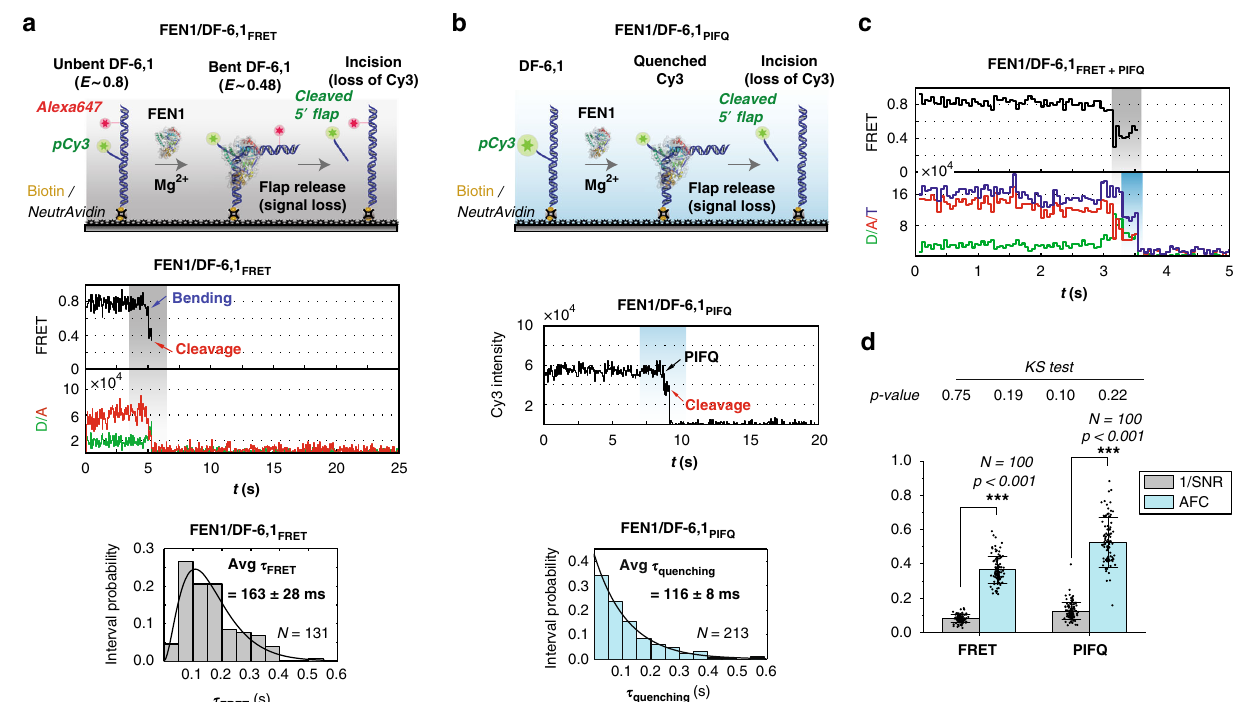
Fig. 5 PIFQ can be used at the single-molecule level to infer FEN1 catalytic kinetics. a smFRET cleavage assay used to follow the catalytic kinetics of FEN1 on DF-6,1 substrate. Top: schematic representation of the experimental approach. Bottom: representative single-molecule trace of a cleavage event showing the FRET change and the following loss of signal. The distribution of the time spent in bent state for N = 131 cleavage events was plotted and fi tted with gamma distribution. The mean and standard error of the mean are reported. b Single-molecule cleavage assay (smPIFQ) with a single label (pCy3) placed at the tip of the fl ap. Top: schematic showing the design of the assay. Bottom: representative single-molecule trace monitoring the fl uorescence quenching of pCy3 upon interaction with FEN1 and subsequent signal loss. The time spent in the quenched-state is quanti fi ed for N = 213 events and its distribution is plotted and fi tted to an exponential decay, with the mean and standard error of the mean reported. c Representative smFRET trace showing the FRET change (highlighted in gray) and the total intensity change (highlighted in cyan) before the signal loss. The total intensity change corresponds to the quenching of the Cy3 signal. d Bar chart showing the reciprocal of the signal-to-noise ratio (1/SNR-shown in gray) and the absolute fractional change (AFC-shown in Cyan) (light blue) for smFRET and smPIFQ cleavage traces as described in SI Methods section. The error bars correspond to the standard errors of the mean (SEM) of the 1/SNR and AFC in each case. The analysis was performed using N = 100 traces in both cases. The p -value ( p < 0.001) is calculated for estimating the statistical difference between 1/SNR and AFC using a two-sample t -test for both smFRET and smPIFQ cleavage traces. The inset table shows the p -values generated by the Kolmogorov – Smirnov (KS) test of normality for the four data sets. The KS test failed to reject the null hypothesis that the data is normally distributed as indicated by p > 0.05. Error bars represent SD of N = 100 traces and ± represent SEM. Measurements for a – c were recorded with 50 ms temporal